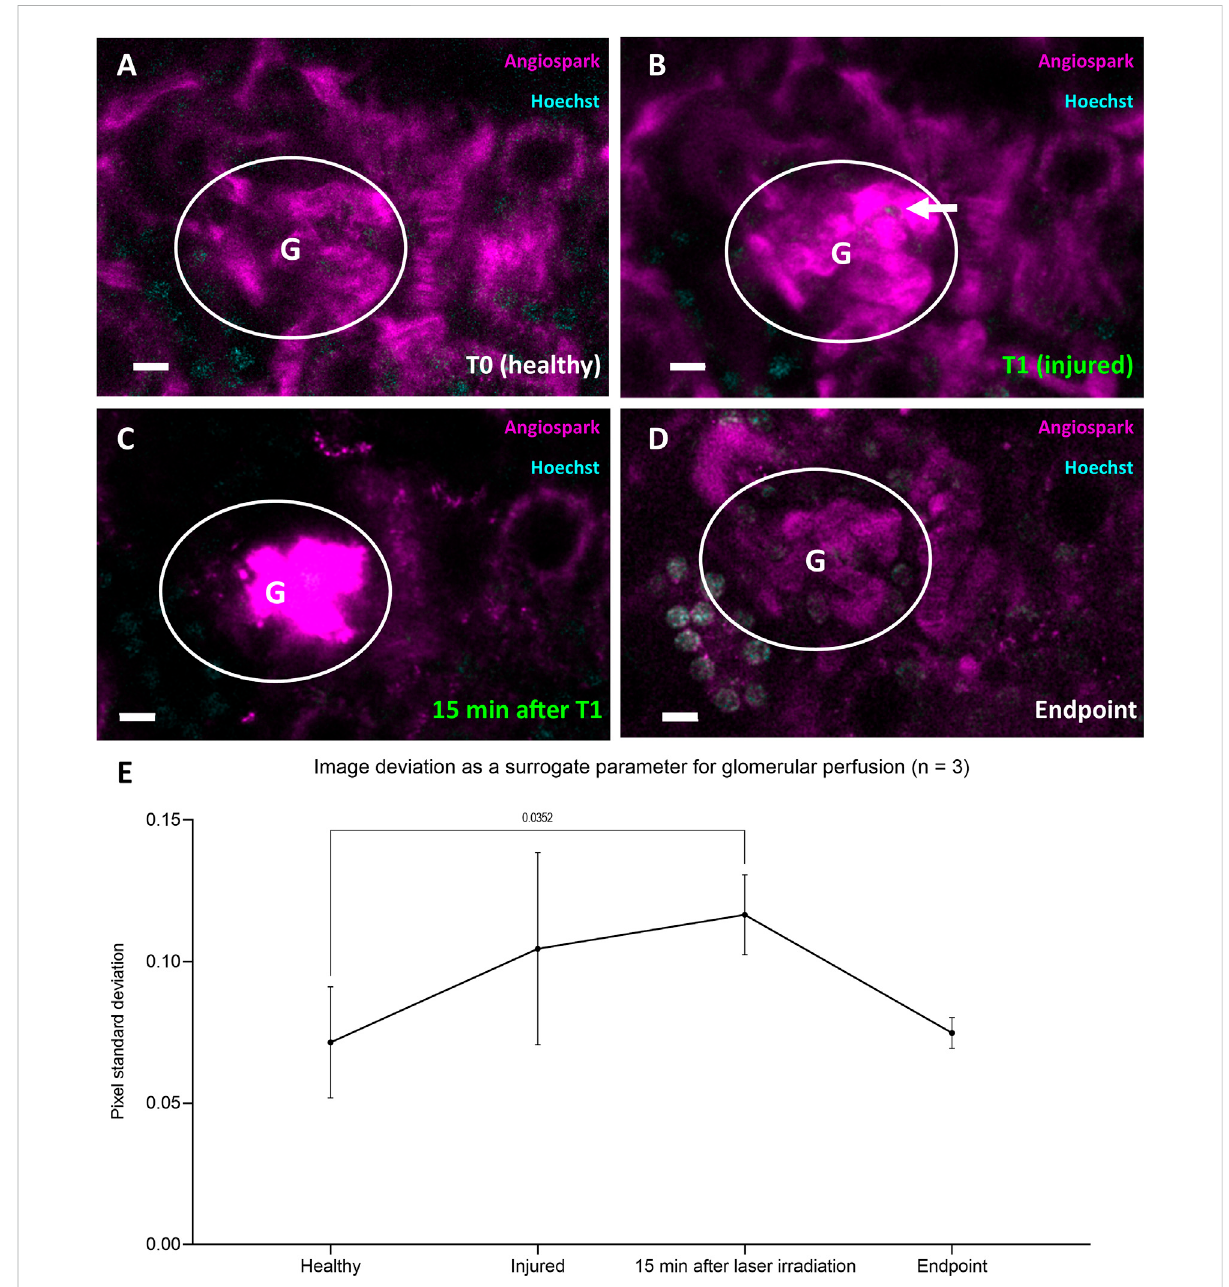
FIGURE 6 Representative dataofglomerularperfusion before,duringandafterlaserirradiation. (A) Representative glomerulusinwhitecircleatfourtime- points healthy at T0 and (B) immediately after laser irradiation (white arrow) at T1. (C) Identical glomerulus 15 min after laser irradiation at T1 with visible Angiospark 680 leakage and (D) at experiment endpoint 96 h after T0. (E) Time-points (A – D) from three glomeruli of three different animals derived image deviation as a quanti fi able surrogate parameter for glomerular perfusion. Image deviation data was compared with two-way ANOVA tests and Tukey ’ s multiple comparisons test calculated individual mean ± SD values. White scale bars represent 10